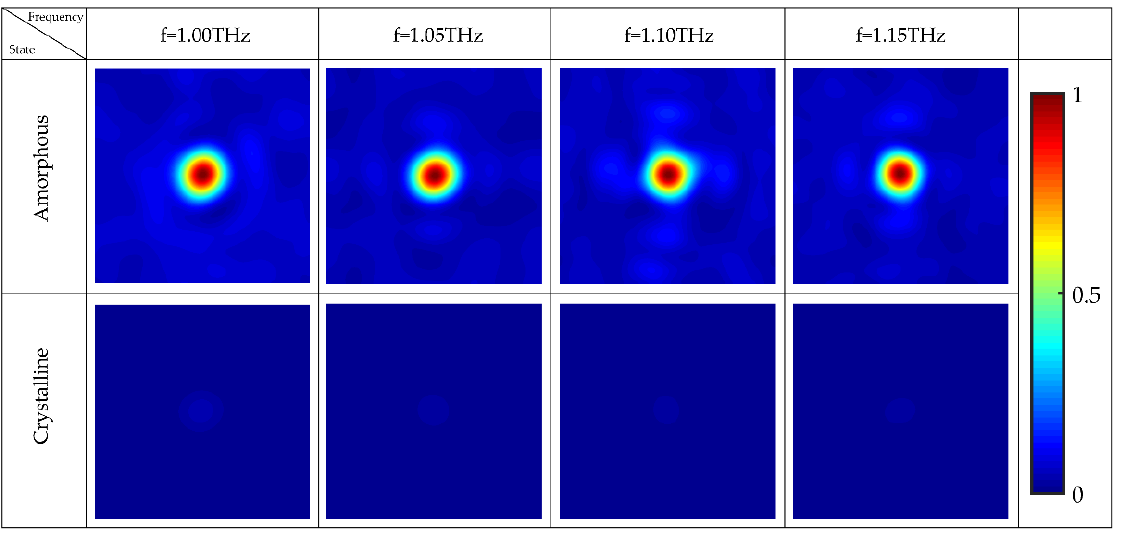
11 of 15 Figure 8. Under illumination of 1.05 THz LCP light, the sectional views of GST in amorphous ( a , b ) and crystalline ( c , d ) on focal plane z = 500 μm and plane y = 0 μm of the focusing metalens. ( e ) Electric field intensity distribution of z = 500 μm sectional view along x -axis in GST two states. When the frequency of incident circularly polarized light changes, to make focusing metalens cover 0~2π phase, the rotation angle φ of unit cells should be changed, to con- stitute different metalens for different incidence light frequencies. In this paper, we rede- sign focusing metalenses for LCP light with the frequency of 1 THz, 1.1 THz, and 1.15